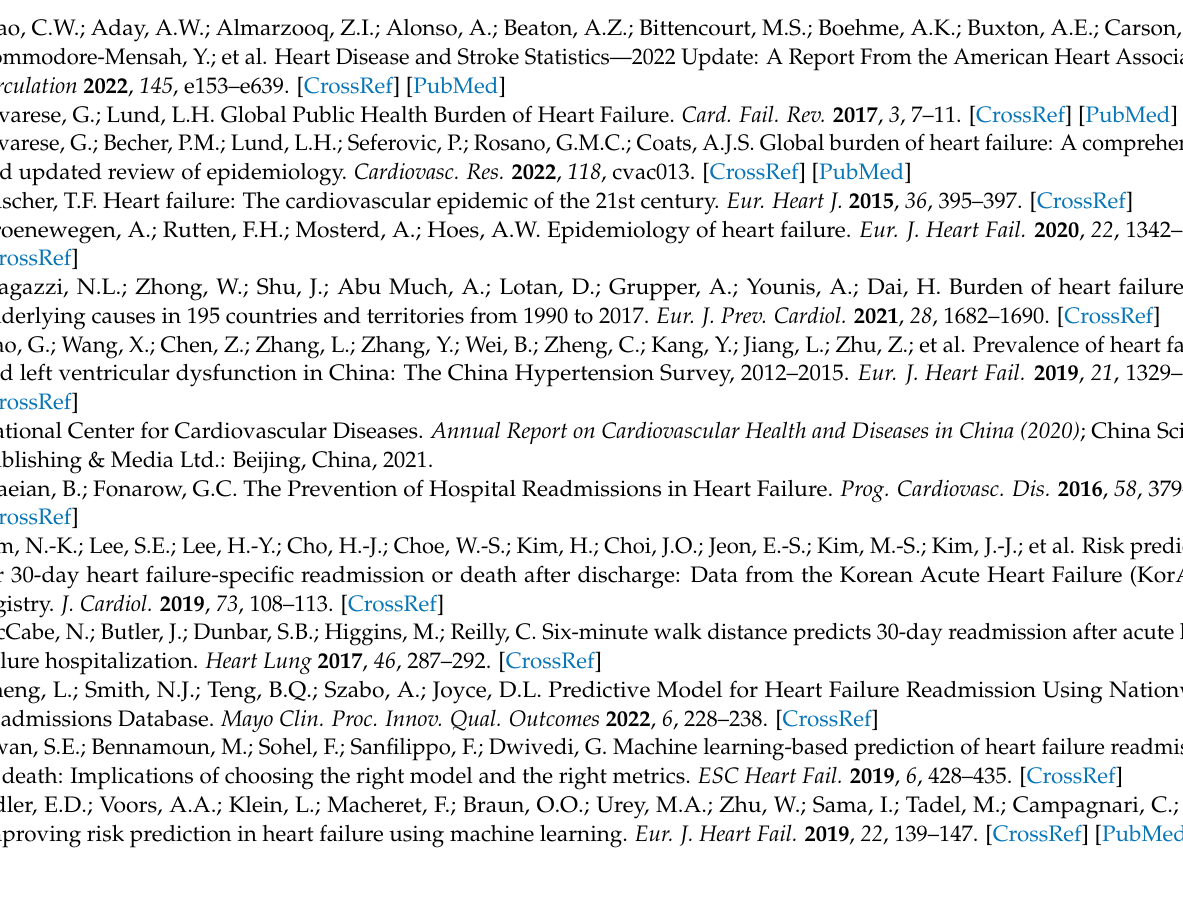
screening methods; Table S3: The statistical parameters and p-values of the 12 variables; Table S4: The criteria or statistical parameters for the six prediction models; Table S5: The results of the three variable screening methods are used to construct the model separately; Table S6: Comparison of the predictive power of a 10-variable LR model with a 12-variable LR model; Table S7: The results of